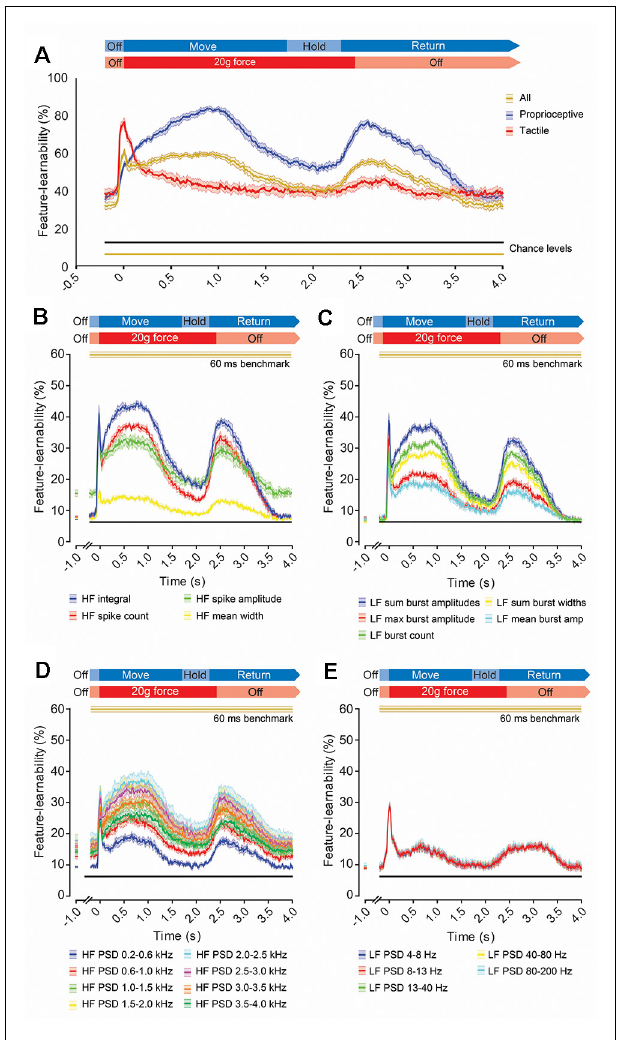
FIGURE 7 | Evolution of feature-learnability from 60 ms windows during natural mechanical stimuli. (A) Feature-learnability time-series determined by extracting features from a 60 ms sliding window advanced every 10 ms are shown for the 60 ms benchmark feature set of 17 features ( Figure 6E ) for all stimuli (gold trace), as well as modified neural networks restricted to proprioceptive- or tactile-dominated inputs/outputs only (indicated by blue and red traces respectively). Expected feature-learnability by chance is indicated for all (gold) and proprioceptive- and tactile-dominated (black) stimuli. (B–E) Feature-learnability time-series at 1,000 ms pre-stimulus and from 200 ms pre-stimulus to 4,000 ms post-stimulus are shown in their HF (B) , LF (C) , HF PSD (D) , and LF PSD (E) signal feature categories. Colored lines and shading indicate the feature-learnability (mean ± SEM) for each signal feature (colors arbitrarily chosen). Gold lines indicate the 60 ms window benchmark feature-learnability ± SEM ( Figure 6F ) for comparison; black straight lines indicate classification chance level (6.25%). See Figure 2 for feature descriptions and